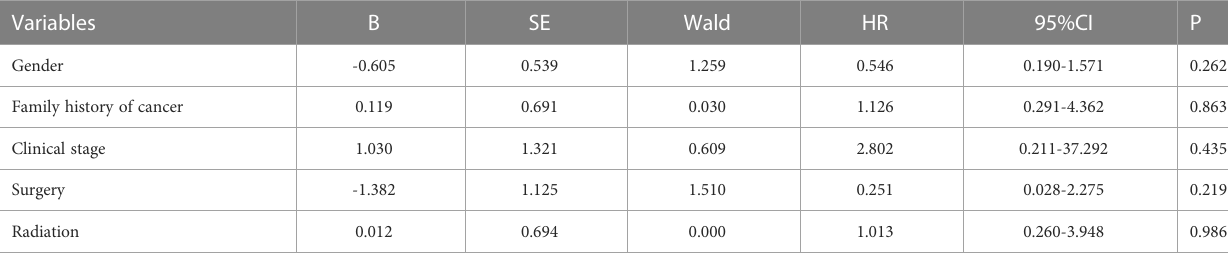
TABLE 3 Multivariate Cox regression models associated with